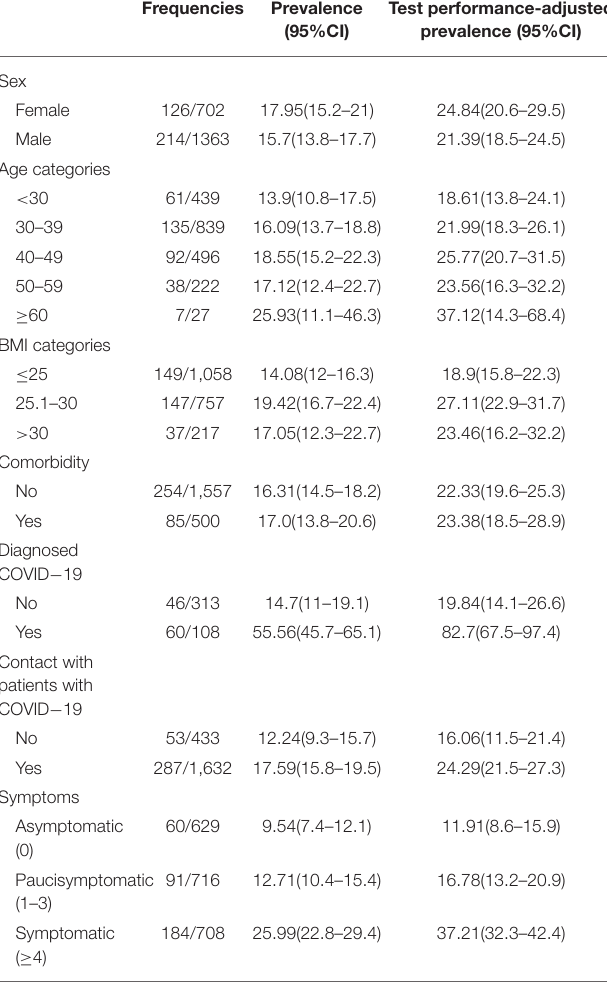
TABLE 5 | Frequencies and prevalence of seropositive tests stratified according to baseline